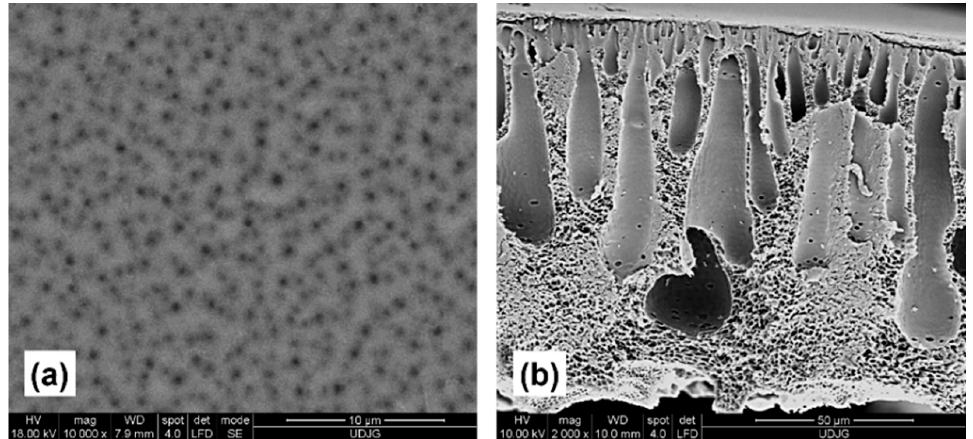
Figure 1. SEM images of control membrane (25 wt.% PSf): ( a ) surface and ( b ) cross ‐ section.